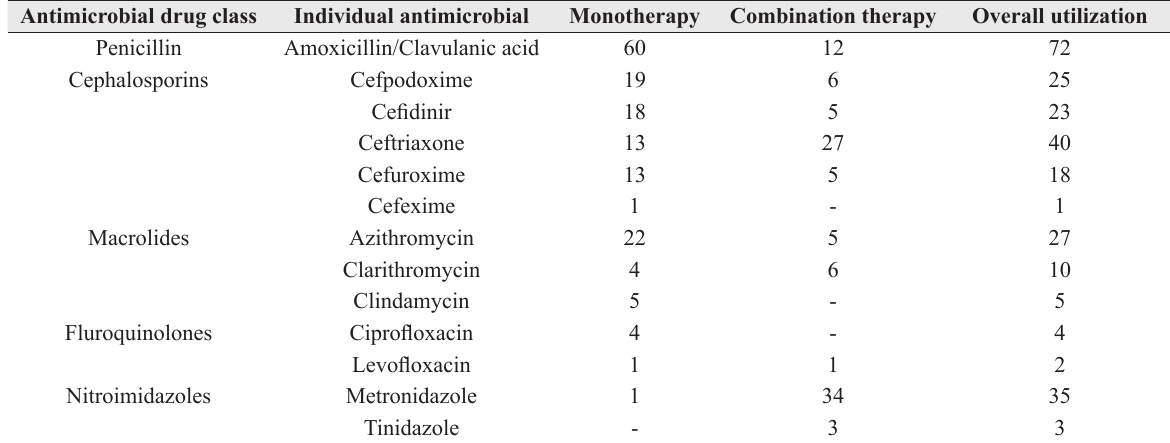
Pattern of monotherapy and combination therapy in acute